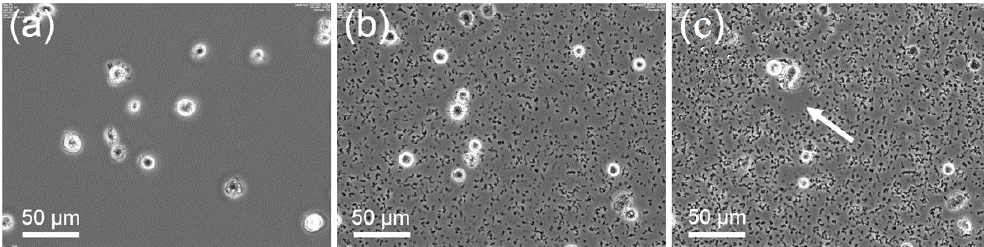
Figure 2. Progressive gravitational settling of ZrO 2 -TODS in the presence of NR8383 cells. Phase contrast images were taken from a time-lapse observation series 3 min ( a ), 75 min ( b ), and 150 min ( c ) after addition of particles (11.25 µ g/mL). A moving NR8383 cell has just cleared a small area (arrow in c ) from particles.